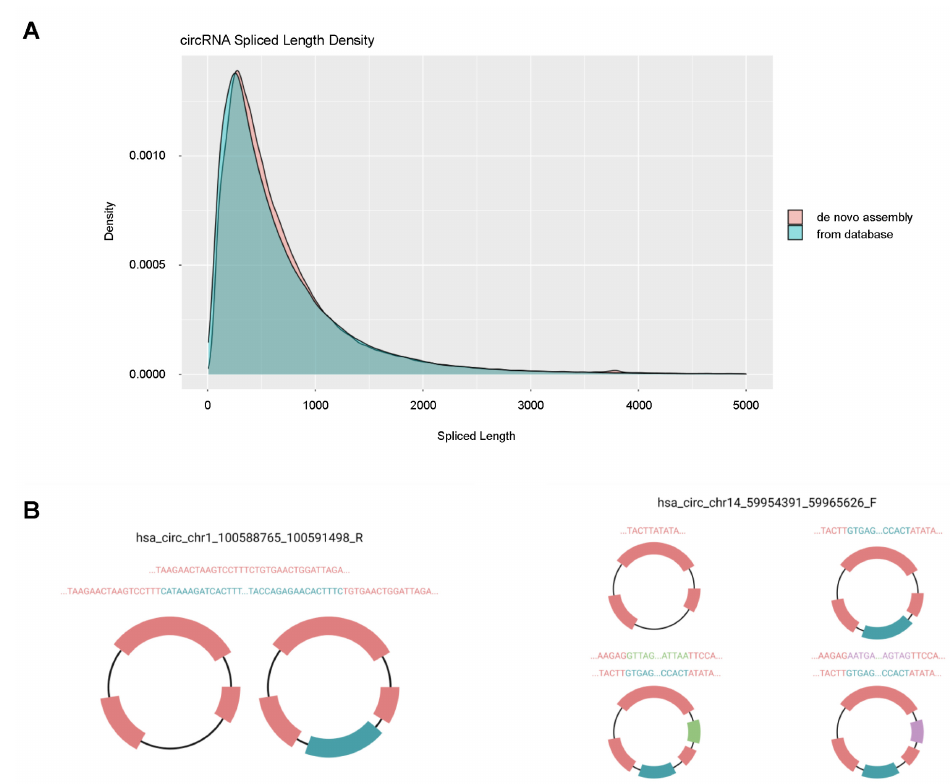
Figure 6. Spliced length density plot. ( A ) The spliced lengths of circRNAs calculated using the STAR aligner on FASTQ files obtained from the GEO/SRA public database is shown (aqua) compared to the density of spliced lengths of circR- NAs from the de novo assembled body approximations (pink). The extensive overlap of the two curves suggests that the body size approximations of the circRNAs in this study are only slightly larger than those determined from gene models in the GEO/SRA database. ( B ) Two examples of circRNAs displaying alternative de novo assembled isoforms: hsa_circ_chr1_100588765_100591498_R and hsa_circ_chr14_59954391_59965626_F. These isoforms were created by exon skipping and not picked up by the default module of